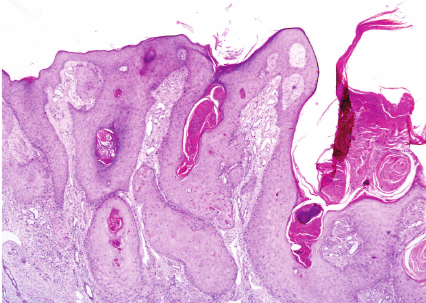
Figure 6: Infundibulocystic hyperplasia: skin lesion showing follic- ular proliferative process with bland squamous cells and formation of dilated canals containing keratotic material. (H&E, × 40).